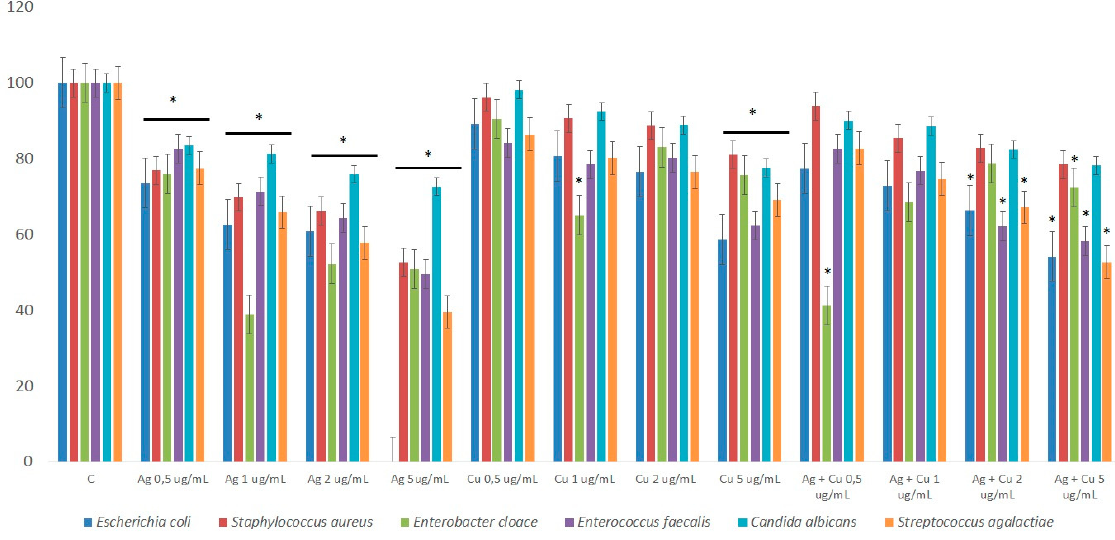
Figure 4. Membrane integrity of HMEC cells (*—differences significant at p < 0.05).